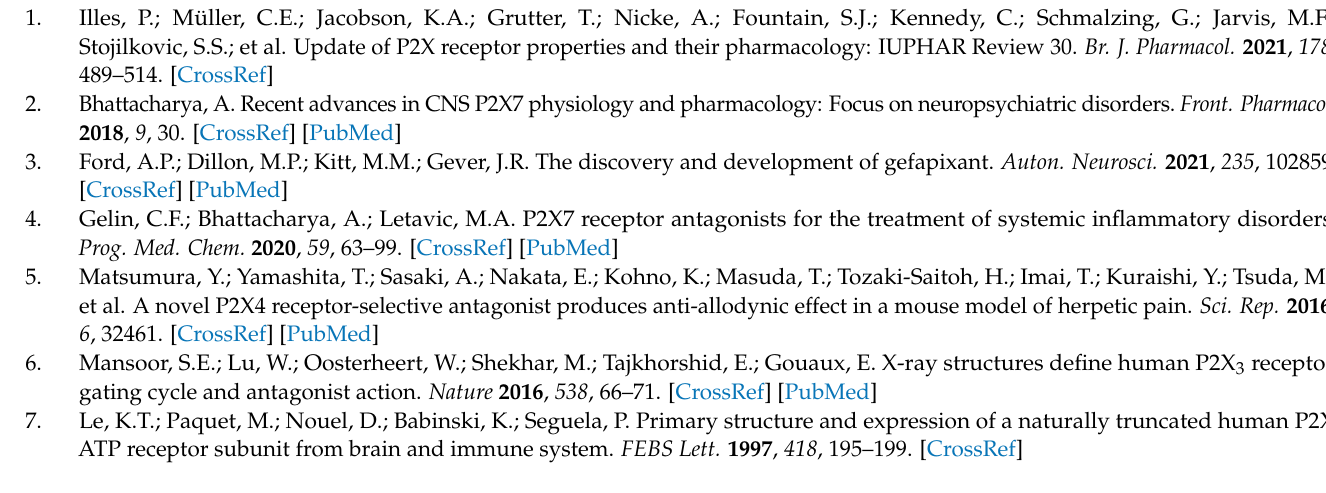
in bold italics are conservatively different in rat P2X5. The bolt-blue underlined stretches of residues mark the transmembrane domains TM1 and TM2. The residue stretches highlighted in red and salmon refer to the head domain and the left flipper, which are shown in Supplementary Figure S2 with the same color code. Also shown are individual residues involved in ATP binding in lime-green. Figure S2—3D structure of a hP2X5 FL protomer modelled with AlphaFold 2. The 3D structure of the hP2X5 FL subunit was modelled by using AlphaFold 2 (https://cryonet.ai/af2/, accessed on 10 January 2022) and visualized using Pymol version 2.5.2 (http://www.pymol.org/, accessed on 10 January 2022). Residues encoded by exon 10 are highlighted in light green and include the pre-TM2 region and the following two-thirds of TM2. For better orientation, the head domain and the left flipper are highlighted in red and salmon, respectively. The two leucine residues, which are phenylalanines in the NCBI sequence NM_002561 [16], are indicated in magenta in the stick presentation. In addition, conserved residues involved in ATP binding as green